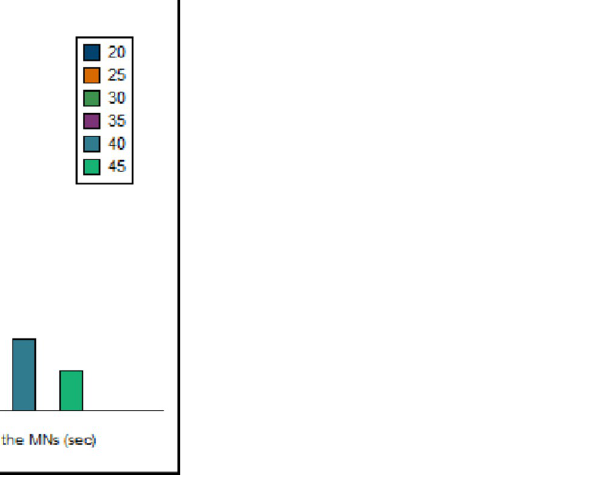
Fig 15. Signaling cost vs. stability of